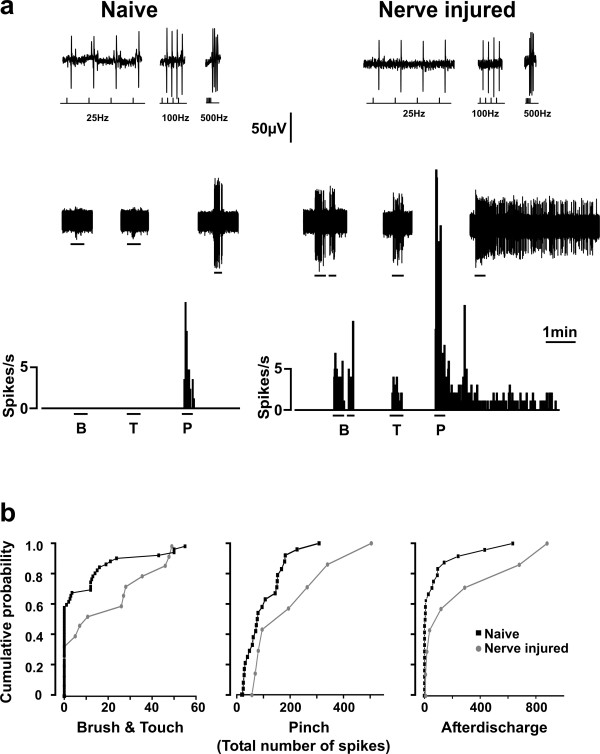
Nerve injury alters the sensory specificity of lamina I projection neurons. a. The majority (79%) of lamina I projection neurons in naïve rats were nociceptive specific whereas the majority (58%) of those recorded in nerve injured rats responded to both noxious and innocuous stimuli. The rate meter records show representative responses to natural stimuli (B = Brush; T = Touch; P = Pinch) of two identified lamina I projection neurons in a naïve rat and a rat with nerve injury. The inset shows the responses of the cells to trains of stimuli delivered in the parabrachial nucleus at decreasing interspike intervals; the cells followed > 500 Hz stimulation confirming antidromic activation (see methods and Fig. 1b). b. The cumulative probability plots show a significant increase in the response to innocuous (data from responses to brush and touch were pooled) and noxious (pinch) stimulation of the hind paw in lumbar spinal lamina I projection neurons after nerve injury. Results are expressed as total number of spikes during the stimulus for response to Brush/Touch and Pinch and throughout the duration of the afterdischarge (in other words, area under the curve).